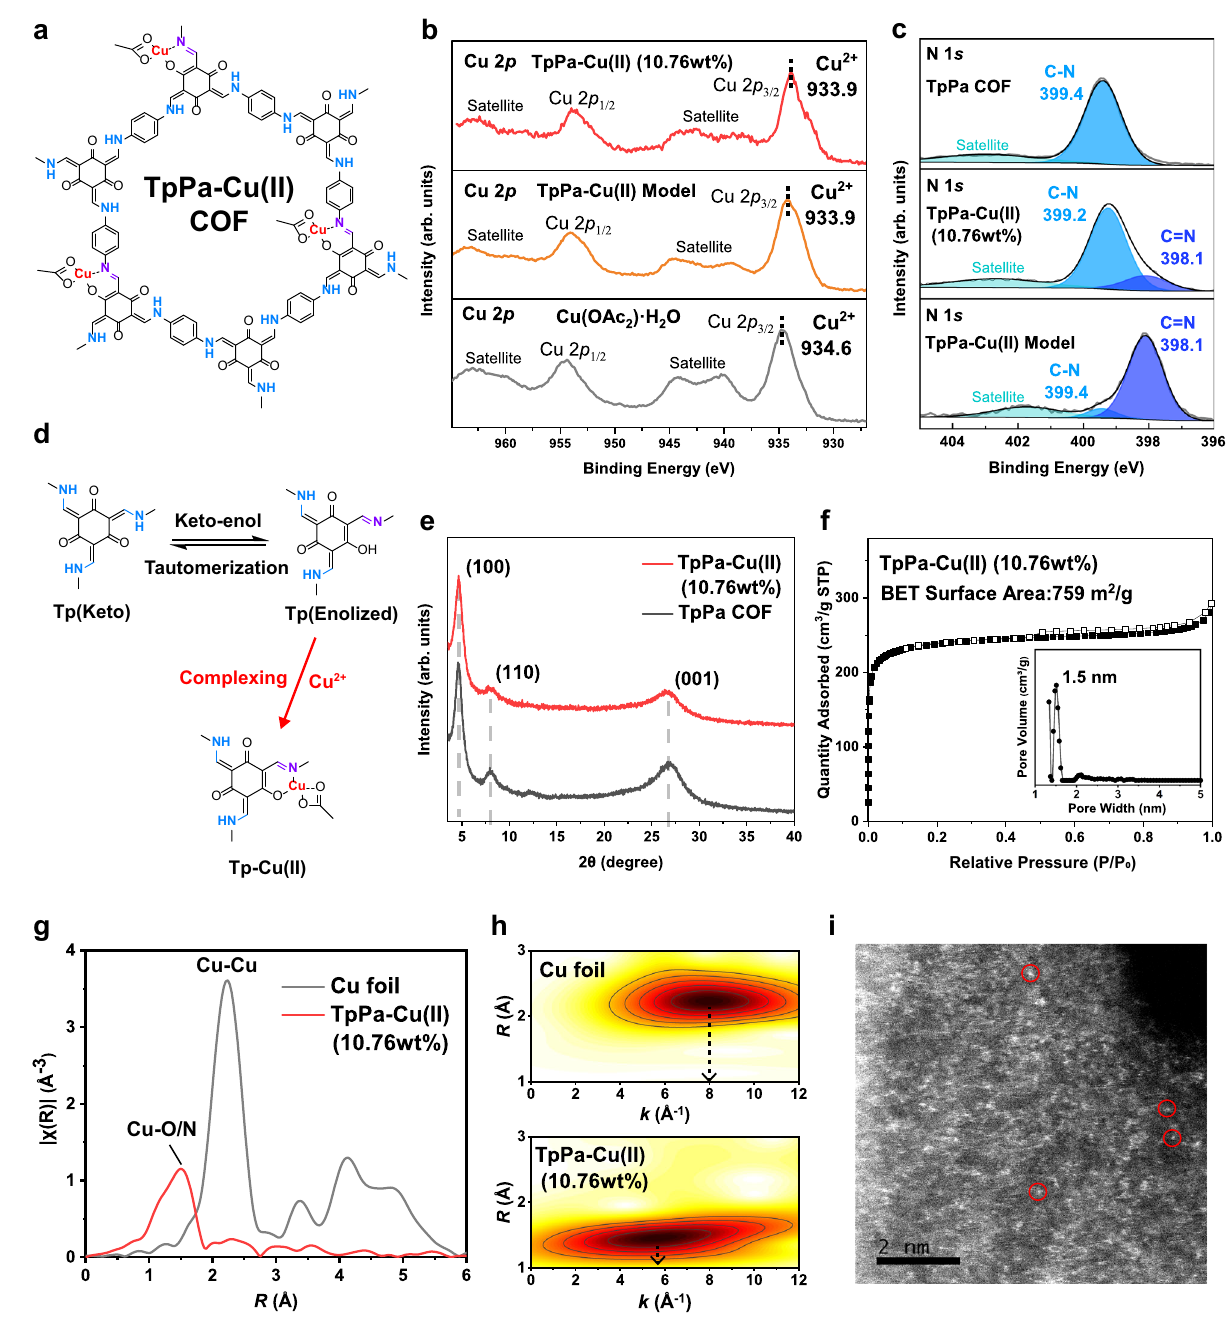
f Nitrogen adsorption (solid circle) and desorption (open circle) isotherm pro fi les and pore-size distribution (inset) of the TpPa-Cu(II)-COF(10.76wt%). g The r-space distributionsand h the waveletanalysiscalculatedfrom the k 2 -weighted CuK-edge EXAFS spectra of TpPa-Cu(II)-COF(10.76wt%) and Cu foil (without phase correc- tion). i HADDF-STEM image of the atomically dispersed Cu in the TpPa-Cu(II)- COF(10.76wt%). Source data are provided as a Source Data fi